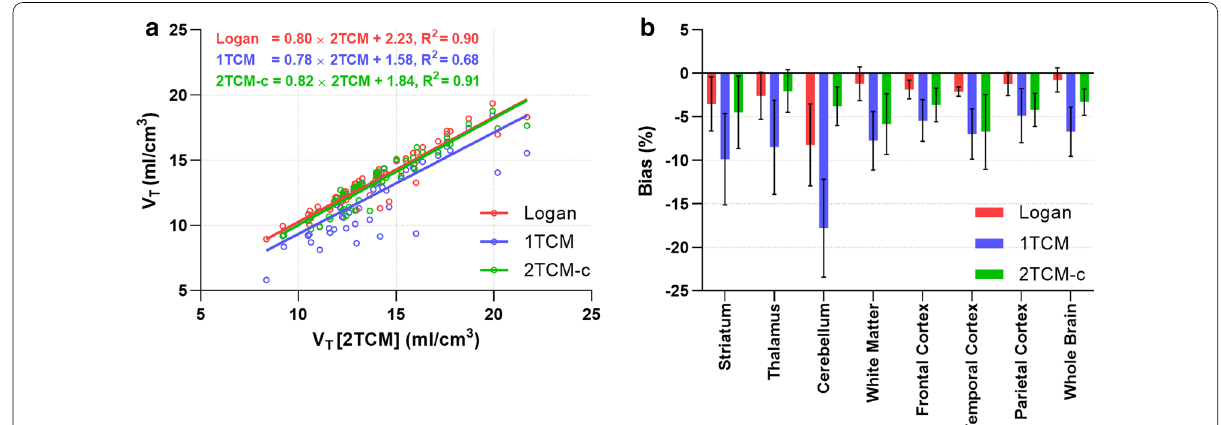
Fig. 4 a Linear correlations show a better agreement between 2TCM, Logan and 2TCM-c as compared to 1TCM. b Overall, Logan and 2TCM-c provide lower underestimation of V T (-3